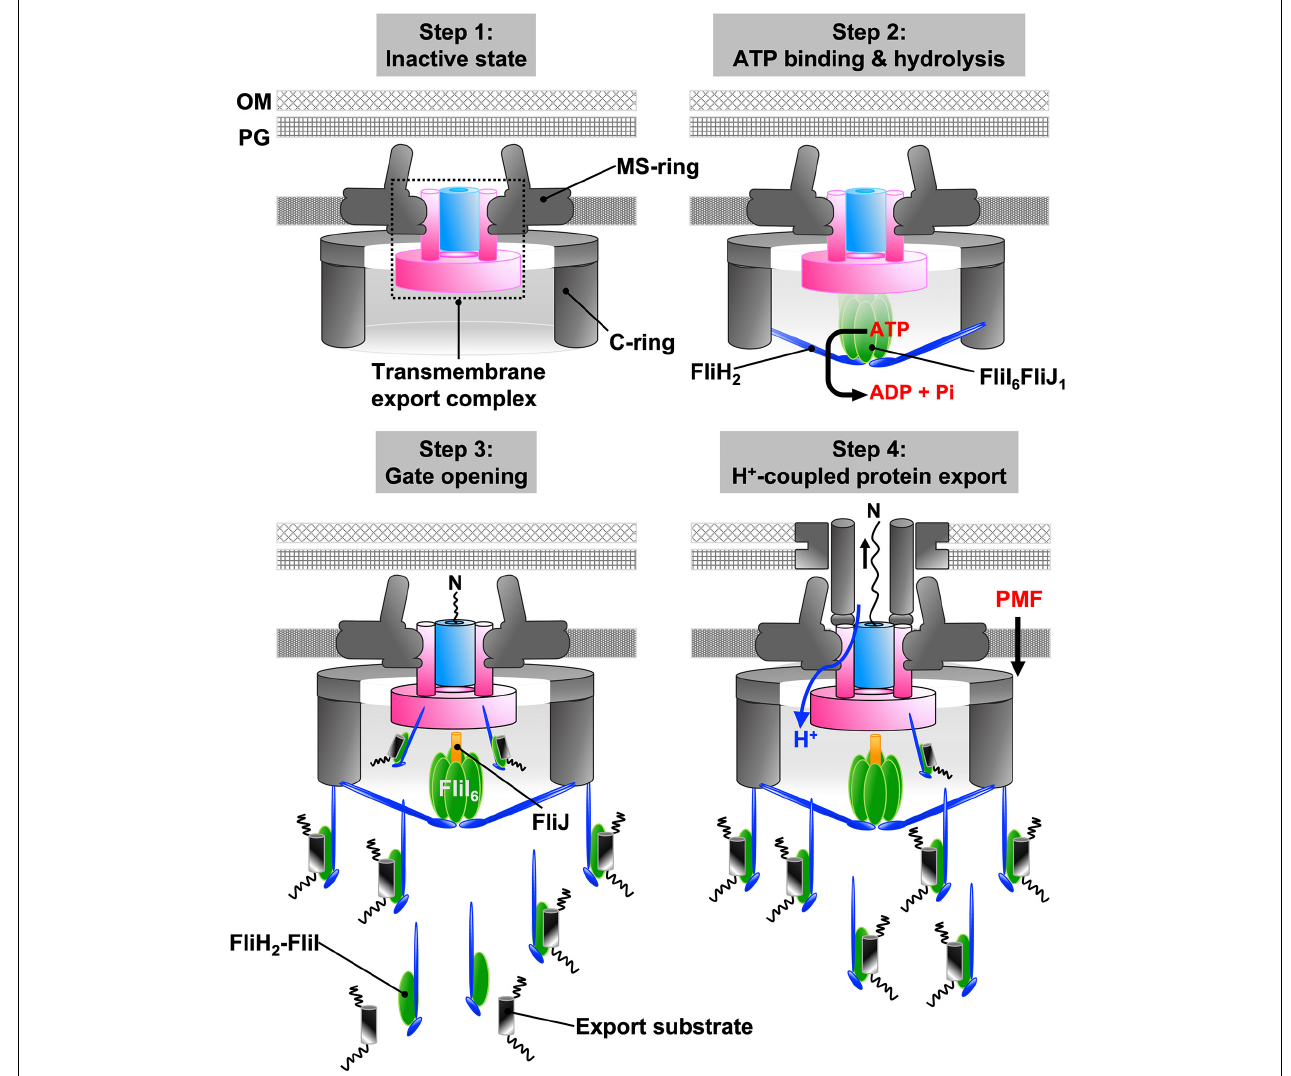
FIGURE 7 | Energy coupling mechanism of the fT3SS. The transmembrane export complex remains inactive until the cytoplasmic ATPase ring complex is formed at the base of the flagellum; the polypeptide and proton channels of the export complex remain closed (step 1). When ATP hydrolysis by FliI induces the rotation of FliJ in the FliI 6 ring, interactions between FliJ and FlhA L induces conformational rearrangements of the export complex. As a result, the complex becomes an active protein transporter (step 2). The cytoplasmic FliH 2 -FliI 1 complex acts as a dynamic carrier to deliver export substrates from the cytoplasm to the export complex (step 3). Upon docking of an export substrate to the entrance gate of the polypeptide channel, the gates of both polypeptide and proton channels are opened. The export complex can now act as a H + /protein antiporter that couples H + flow through the ion channel with protein translocation into the polypeptide channel (step 4).